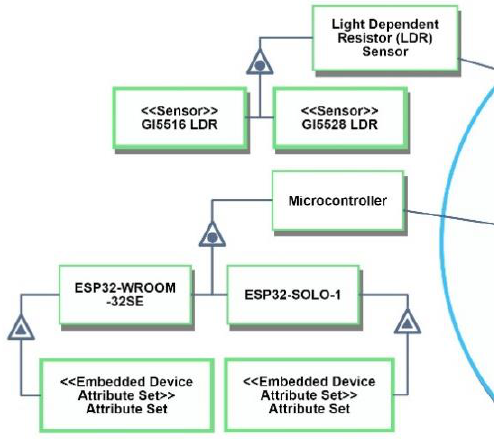
Figure 18. The system sensor and microcontroller instances with their stereotypes.